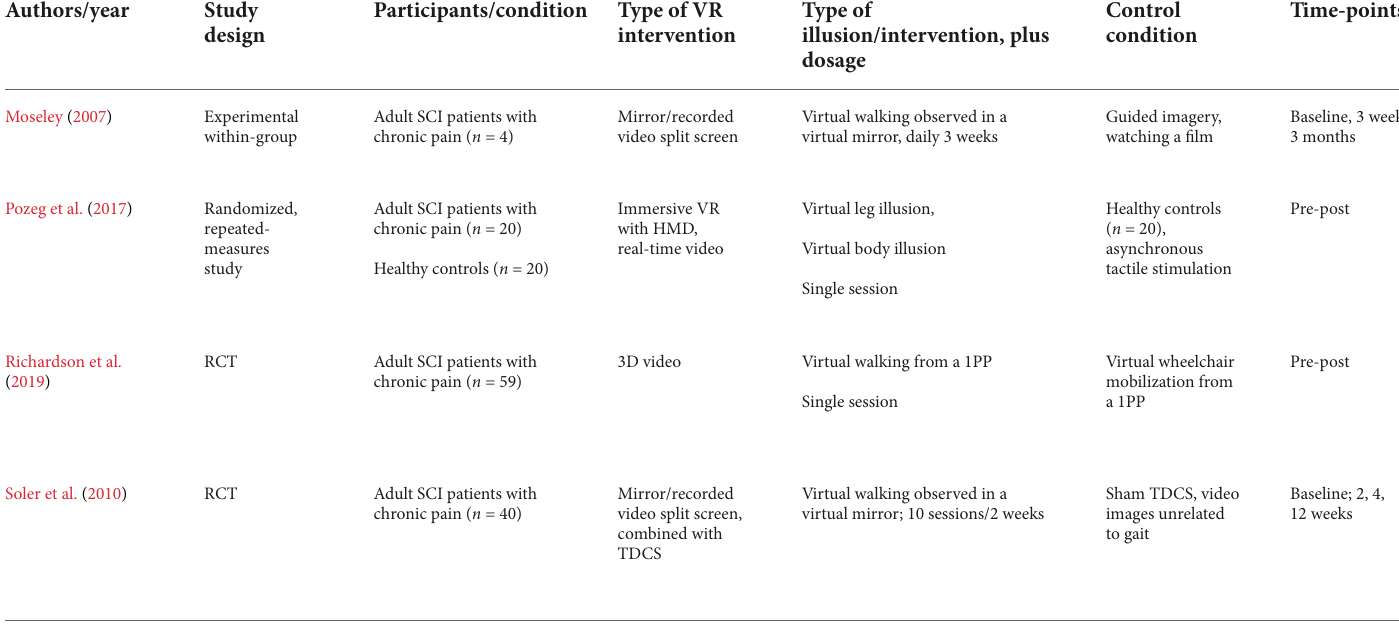
TABLE 2 Summary table of virtual reality studies for the treatment of central neuropathic